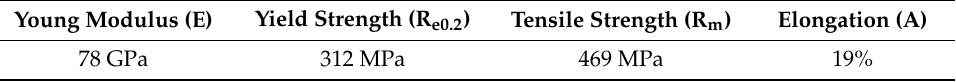
Table 2. Mechanical properties of AA2519-T62 [34].